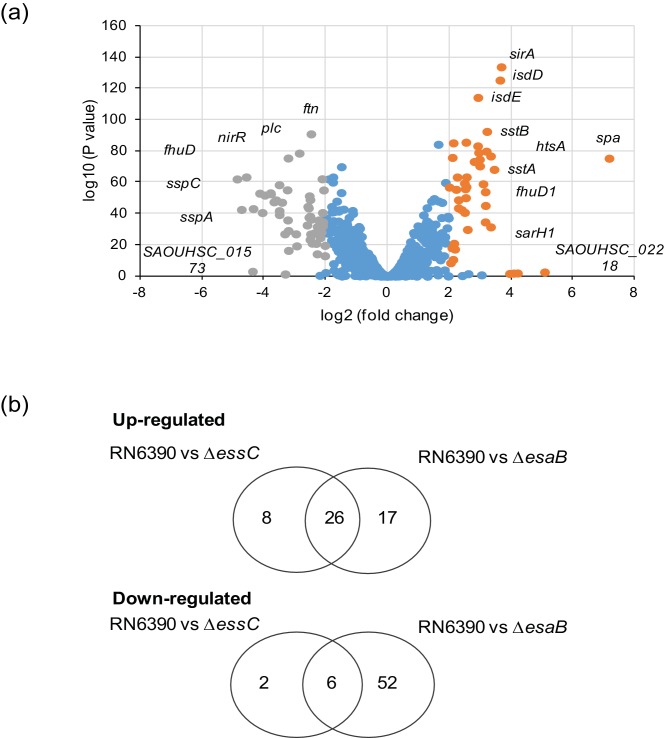
RNA-Seq analysis of differentially regulated genes in the esaB mutant strain. (a) Volcano plot representation of the differentially expressed genes in RN6390 strain compared to the isogenic esaB mutant. The orange and grey spots represent, respectively, genes that are up- or down-regulated in the esaB mutant relative to the parental strain. (b). Overlap between up- and down-regulated genes in the esaB and essC datasets.